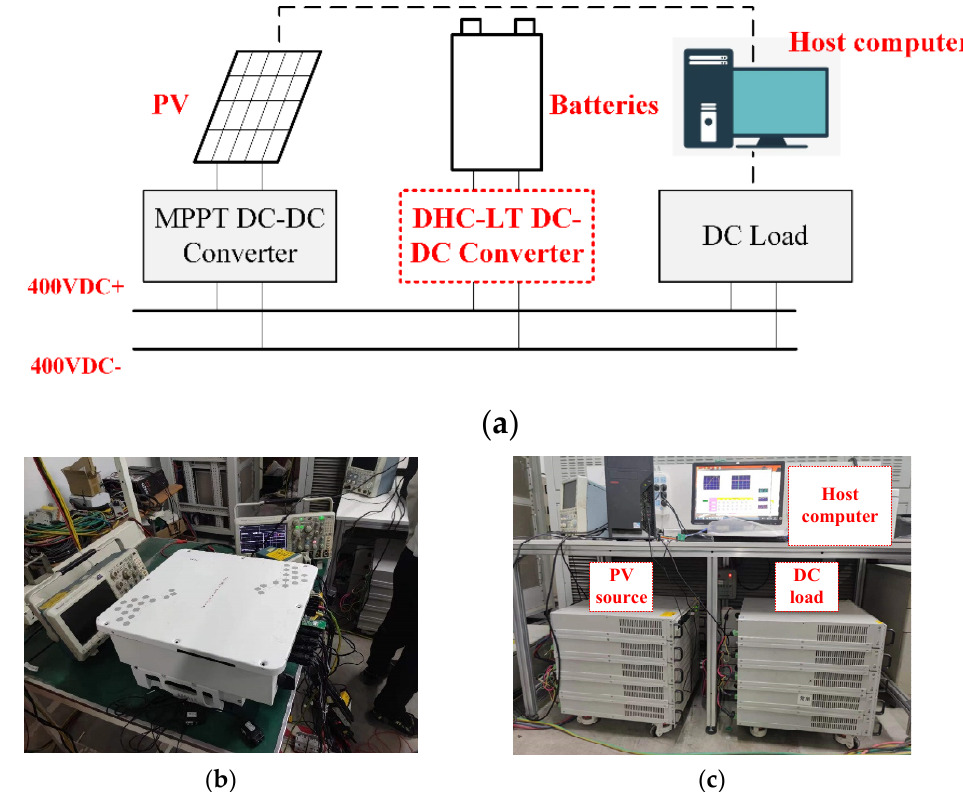
Figure 19. Diagram of battery/PV test system: ( a ) schematic diagram of the whole DC test power system; ( b ) prototype of DC power system; ( c ) DC source, DC load and host computer.